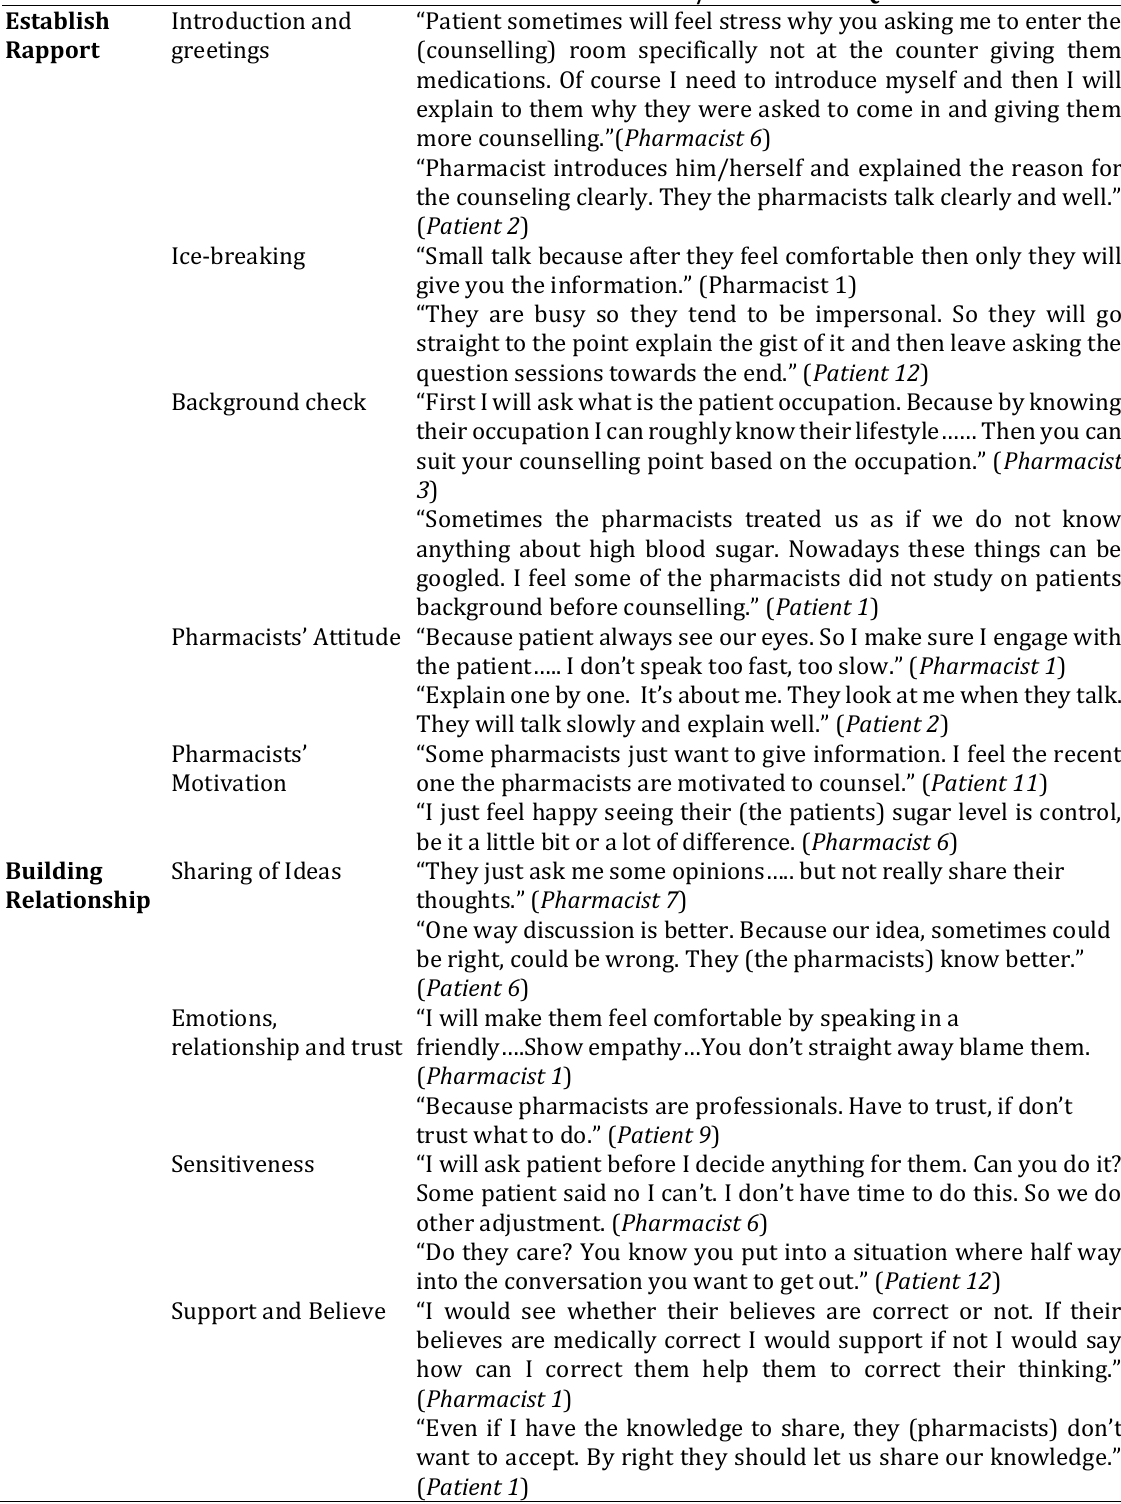
Table 2a. Themes, Sub-themes and Patient’s/Pharmacist’s Quotes